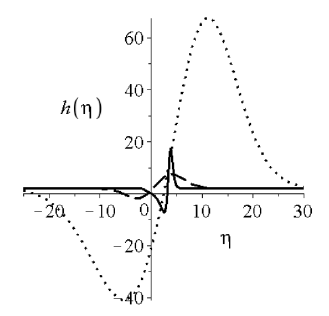
Figure 3. The shape function of the pressure (2.6) for the three parameter sets. The solid curve is for c 4 = 0 . 5 ,a = 0 . 5 ,ν = 1 . 6 ,ρ 1 = 2 ,ρ 2 = 1 the dotted line is for c 4 = 0 . 9 ,a = 0 . 27 ,ν = 10 . 4 ,ρ 1 = 2 ,ρ 2 = 6 and the dashed curve is for